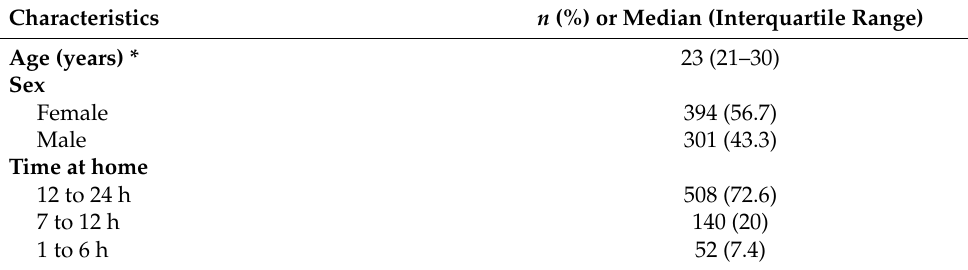
Table 1. Characteristics of the participants ( n =